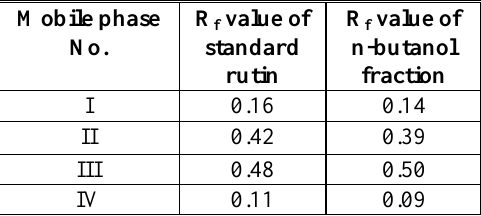
Table (2):- R values of standard rutin f compared with the n-butanol